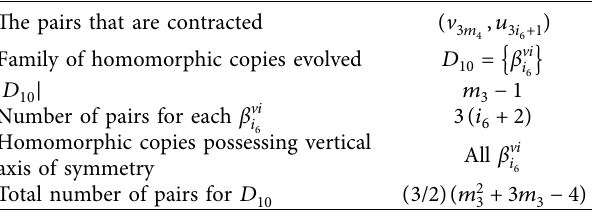
Table 9: Necessary information regarding homomorphic copies 􏽮 􏽯 . β vi i 6